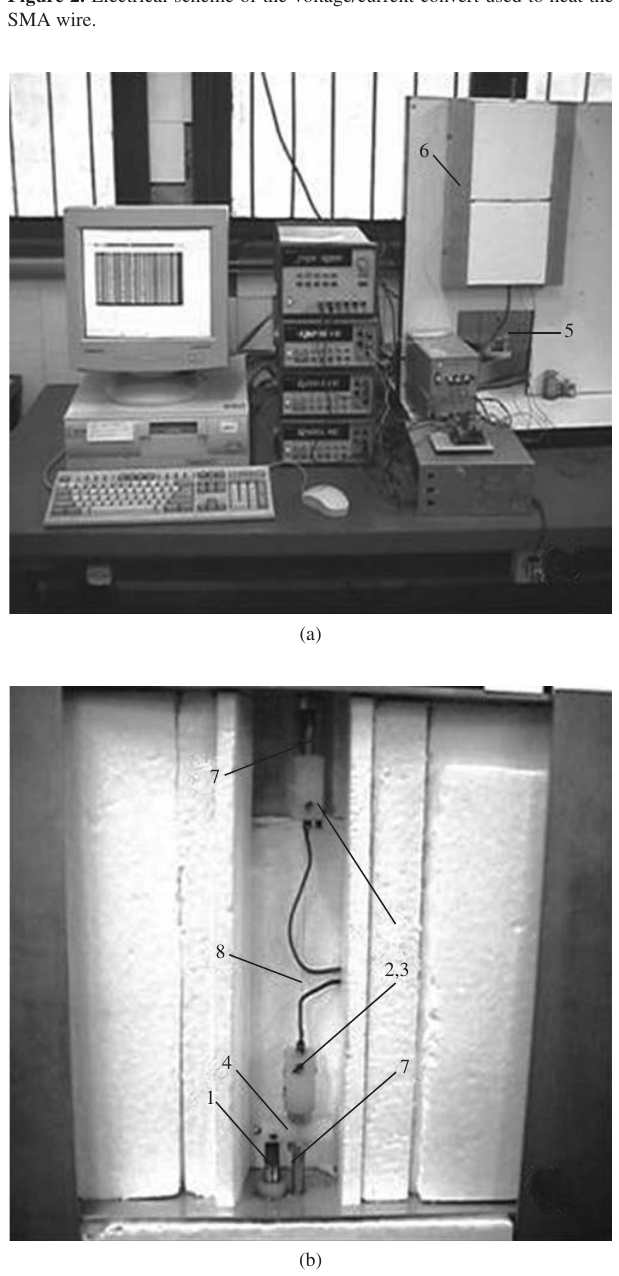
Figure 3. Picture of the test apparatus, a) Entire view; and b) Zoom view of the SMA